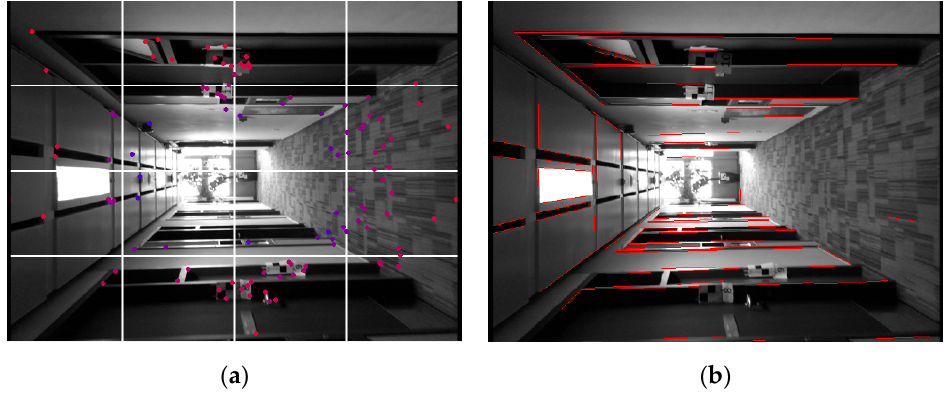
Figure 4. Point and line feature extractor. ( a ) Improved Shi-Tomasi extractor; ( b ) LSD.